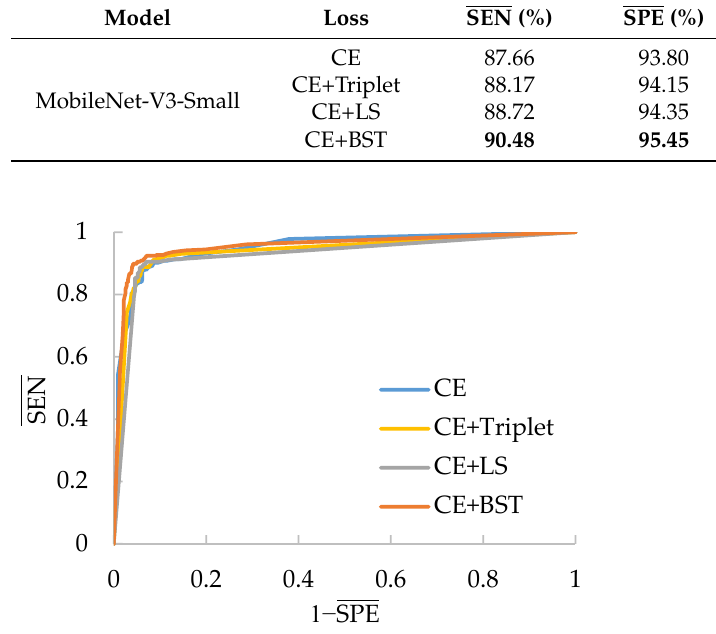
Figure 15. ROC curves of MobileNet-V3-Small with different losses on the osteosarcoma histology image dataset.